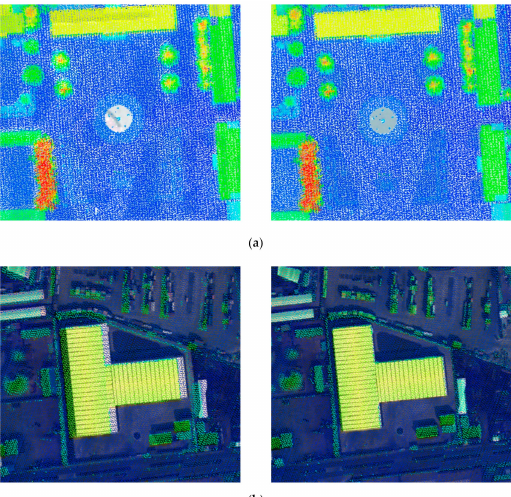
Figure 13. Overlapping LiDAR points with georeferenced images: ( a ) Dataset 1; and ( b ) Dataset